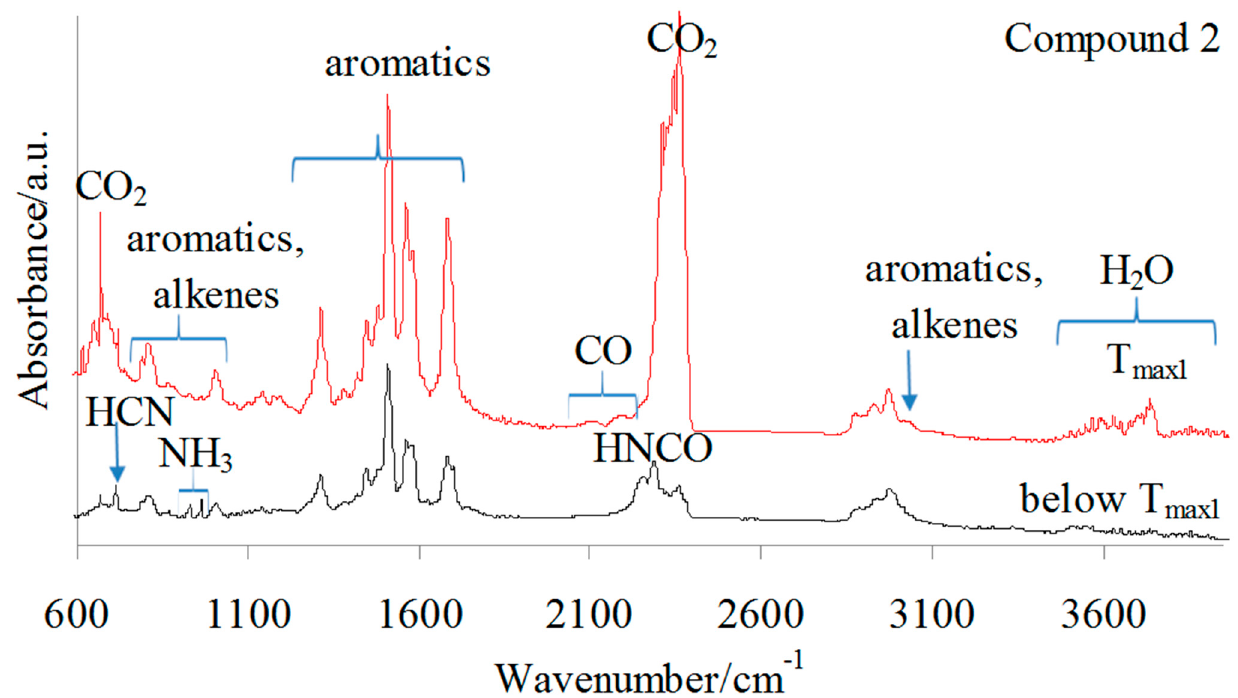
Figure 5. The enlarged FTIR spectrum for compound 2 with marked decomposition products.